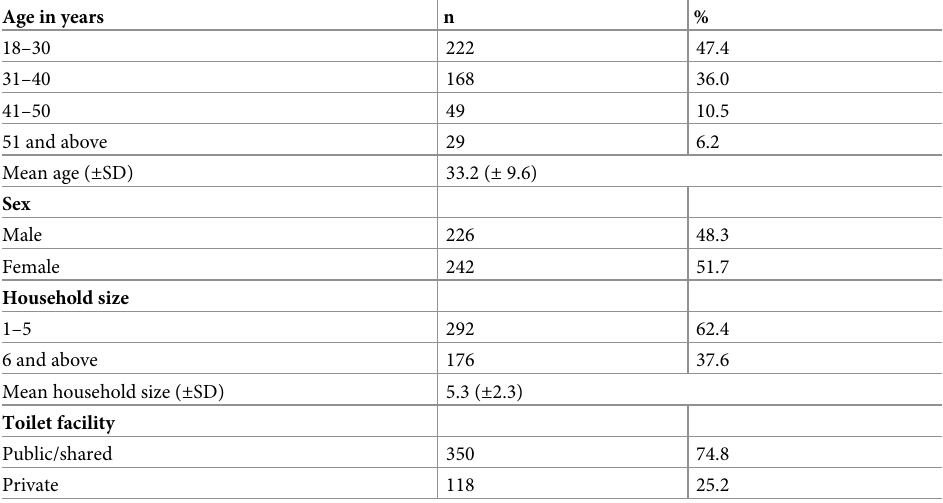
Table 2. Socio-demographic characteristics of the survey participants among Dharavi residents, Mumbai, India (N =